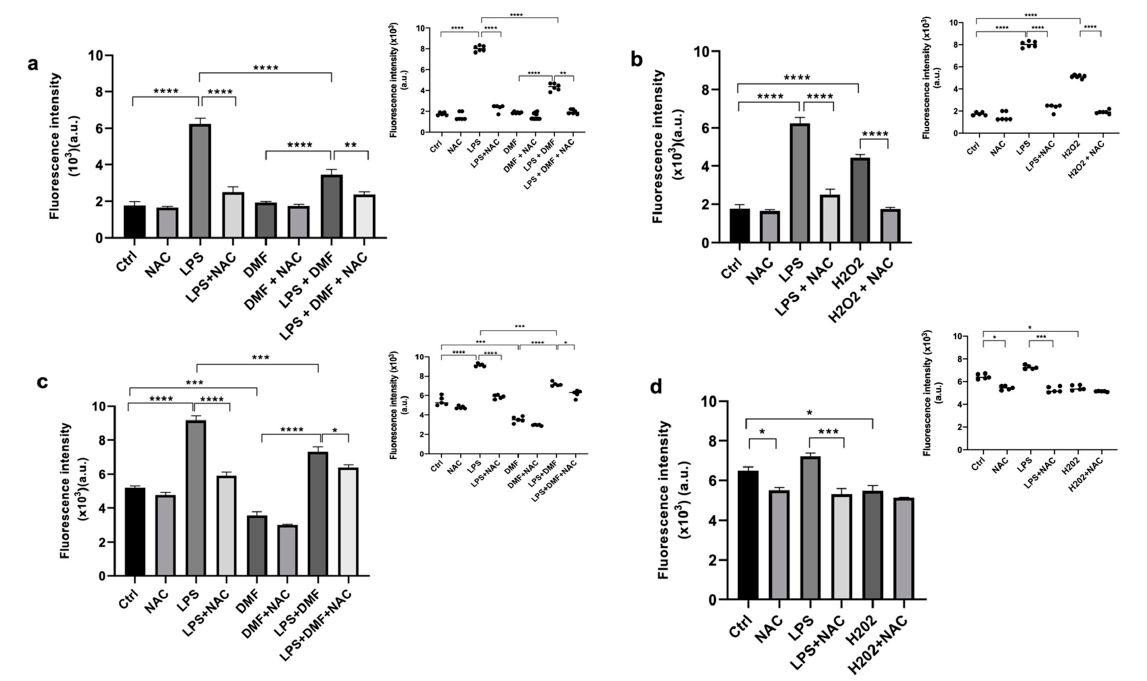
Figure 6. Measurement of ROS levels by DCFDA staining in Oli neu cells under the following experimental conditions: LPS 1 µ g/mL, DMF 25 µ M and LPS 1 µ g/ µ L + DMF 25 µ M, in presence or absence of NAC (10 µ M). Cells were used after 1 DIV ( a , b ) or 5 DIV ( c , d ) from seeding to evaluate the responses of OPC or pro-OLs cells at different experimental conditions. H 2 O 2 (20 µ M) treatment was used as a positive control ( b , d ). The data are the average ± SEM of five independent experiments conducted in sextuplicate. One-way ANOVA test followed by the Turkey multiple comparison post-test was used to statistically compare the different experimental conditions (* p < 0.05; ** p < 0.01; *** p < 0.001; **** p < 0.0001).